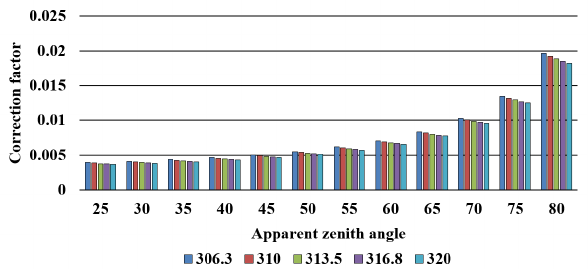
Figure 2. Value of correction factor for the elimination of diffuse radiation impact for the selected zenith angles of the Sun, for five wavelengths for the conditions of AOD with a value of 0.3 (for 320nm) and air pressure of